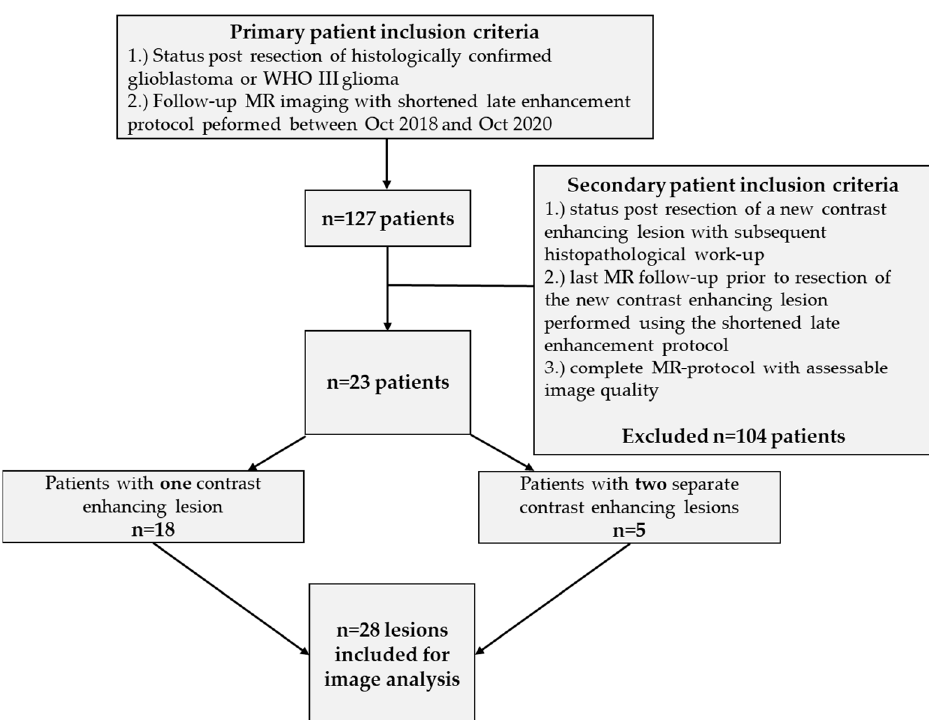
Figure 1. Patient acquisition and inclusion